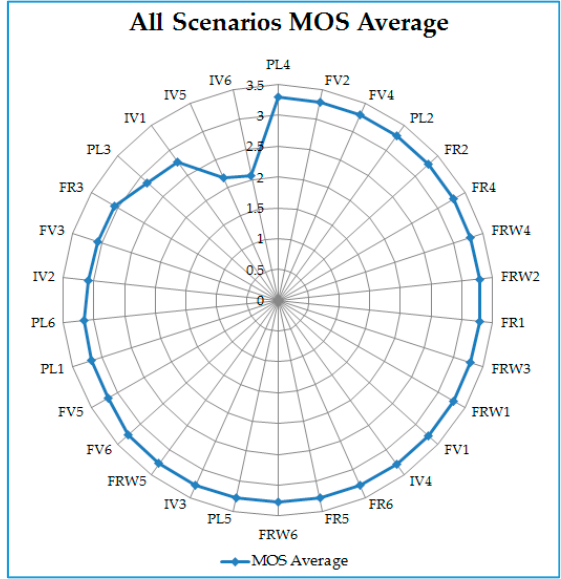
Figure 20. Average MOS values in all scenarios.